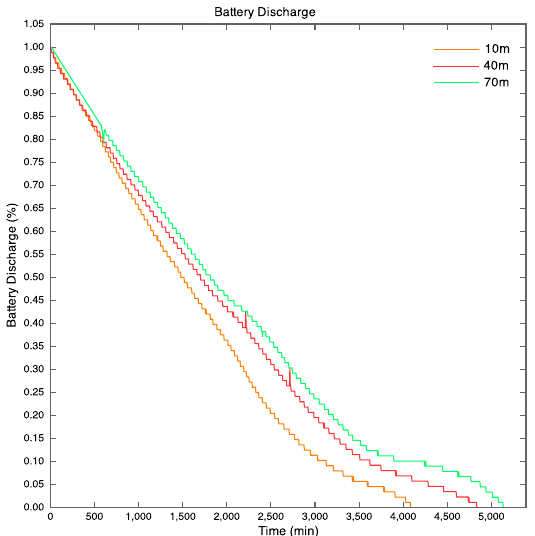
Figure 7. Battery Discharge Curves for Experiment